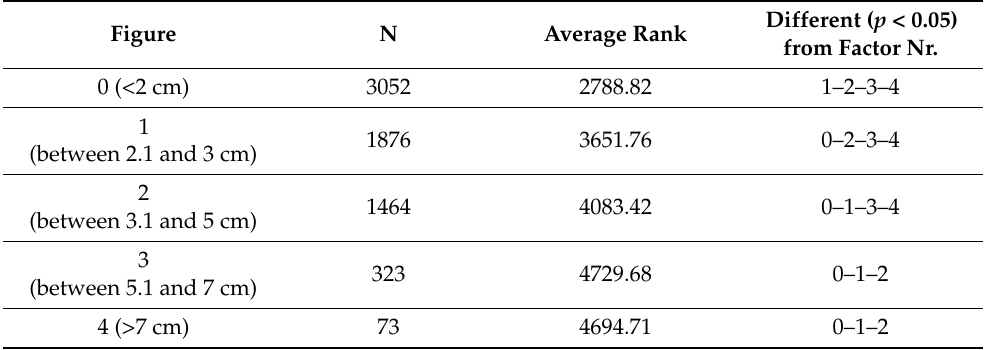
Table 6. Post hoc analysis (Conover) of adenocarcinomas and epidermoid carcinomas based on diameter of